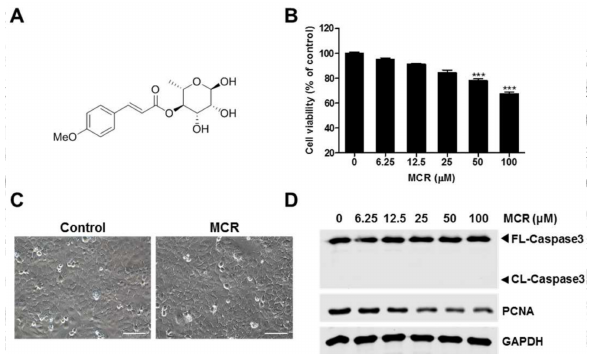
Figure 1. MCR induces minor cell growth inhibition in HaCaT cells. ( A ) Chemical structure of MCR; ( B ) HaCaT cells were treated with indicated concentration of MCR for 24 h, and MTT assay was performed; ( C ) Cells were treated with 50 µ M of MCR for 24 h, and live cell images were obtained using a phase contrast microscope; ( D ) Cells were treated with different concentrations of MCR for 24 h, and lysates were subjected to western blot analysis. ***, p < 0.0001; Bar, 100 µ m.